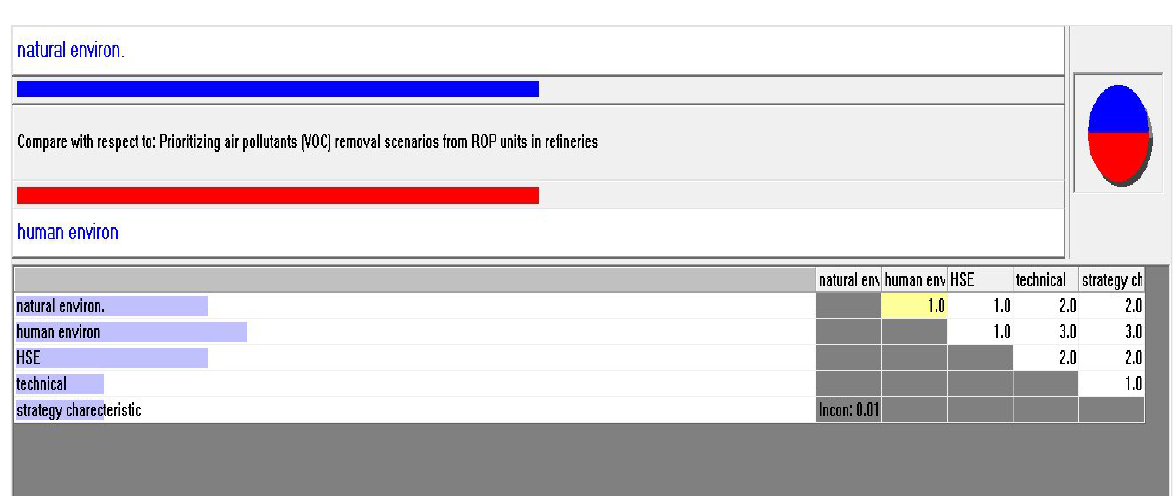
Fig. 2. Schematic image of pairwise comparison of studied components by software